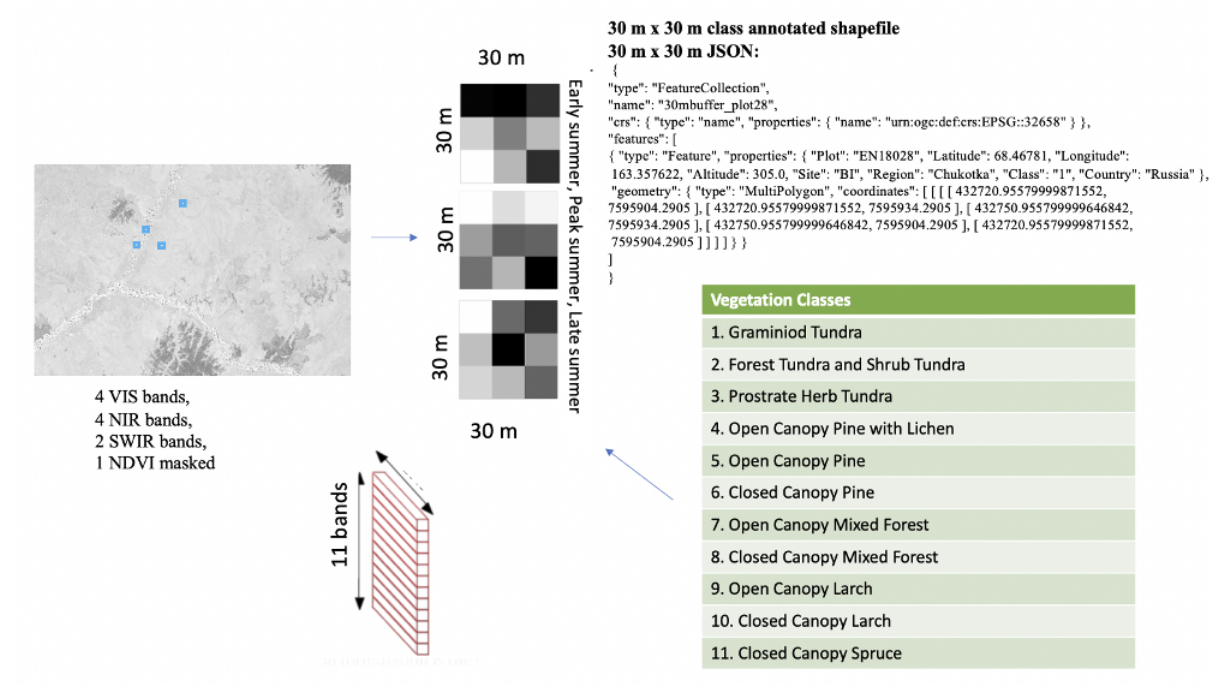
Figure 19. Overview of the products in the Sentinel-2 labeled image dataset, exemplified for plot EN18028.